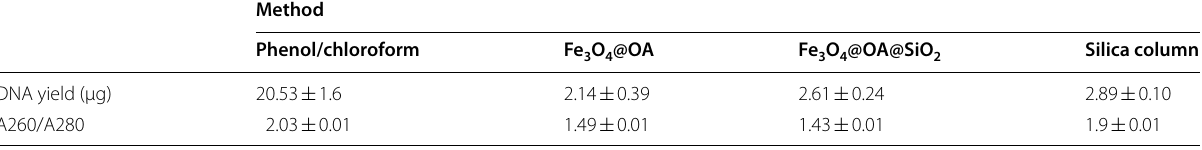
Table 1 Comparison of methods to separate DNA from Arthrospira